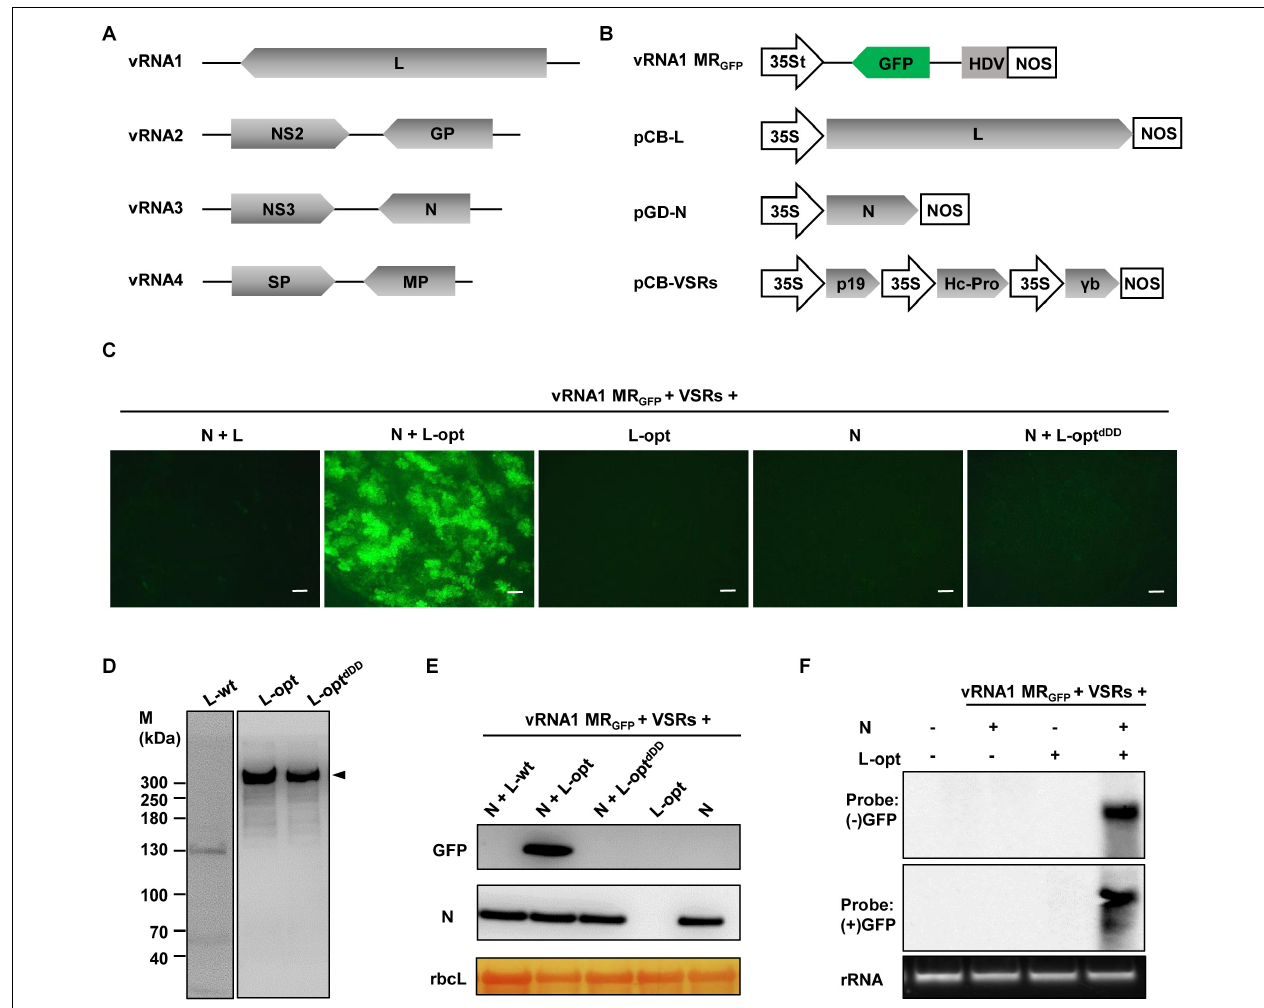
FIGURE 1 | Establishment of a rice stripe virus (RSV) RNA1-based minireplicon (MR). (A) Schematic representation of the RSV genome structure. (B) Illustration of the binary plasmid engineered to transcribe a vRNA1-based MR GFP , in which the virion-sense L coding region was replaced with a green fluorescent protein (GFP) gene. Additional illustrations show the supporting binary plasmids designed to express the N protein and the wild-type or codon-optimized (L-opt) L proteins, and the pCB-VSRs plasmid for simultaneous expression of the tomato bushy stunt virus p19, barley mosaic stripe virus γ b, and tobacco etch virus Hc-Pro viral suppressors of RNA silencing (VSRs). 35S, 35S promoter; 35St, a truncated version of the 35S promoter (Wang et al., 2015); HDV, hepatitis delta virus ribozyme; NOS, nopaline synthase terminator. (C) GFP foci in Nicotiana benthamiana leaves coexpressing vRNA1 MR GFP , VSRs, and N and/or L proteins as indicated above each panel. Agroinfiltrated leaves were photographed with a fluorescence microscope at 5 days post-infiltration (dpi). Scale bar = 200 µ m. (D) Detection of L protein derivatives with L-specific antiserum following transient expression via agroinfiltration. Protein size markers (M) are labeled on the left, and the arrowhead on the right indicates the product corresponding to the full-length L protein ( ∼ 337 kDa). (E) Western blot analyses of the GFP and N proteins expression in infiltrated leaf tissues. The large RuBisCO (rbcL) subunit was stained by Ponceau S to indicate equal protein loading. (F) Northern blot analyses of the replication and transcription products derived from vRNA1 MR GFP . The blots were hybridized with both sense (+) and antisense ( − ) GFP